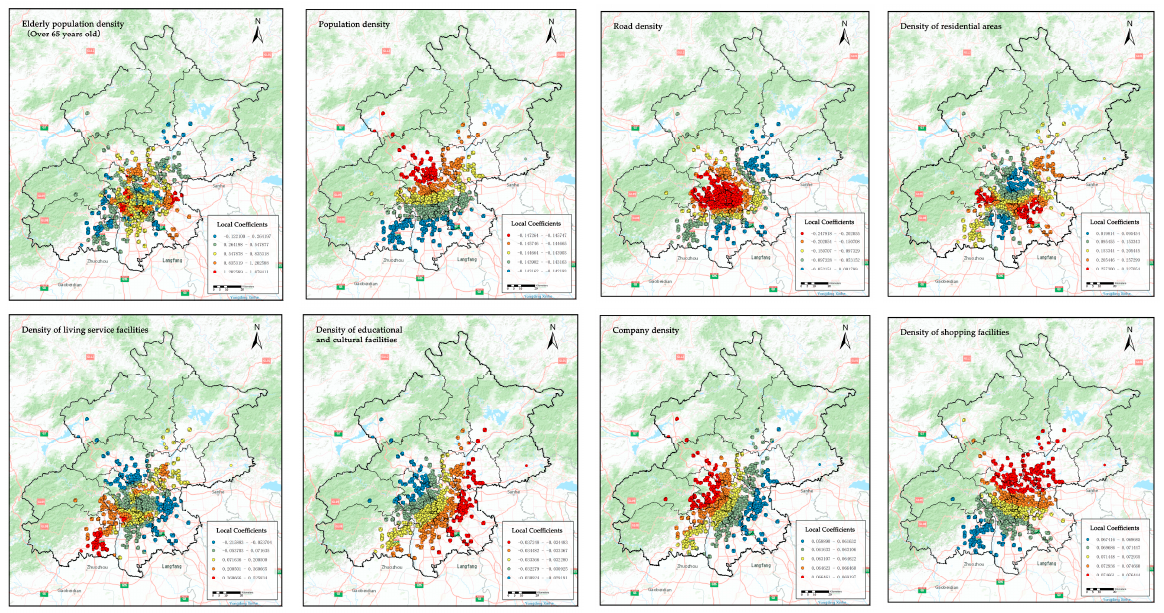
Figure 7. Spatial distribution of the MGWR local coefficients.